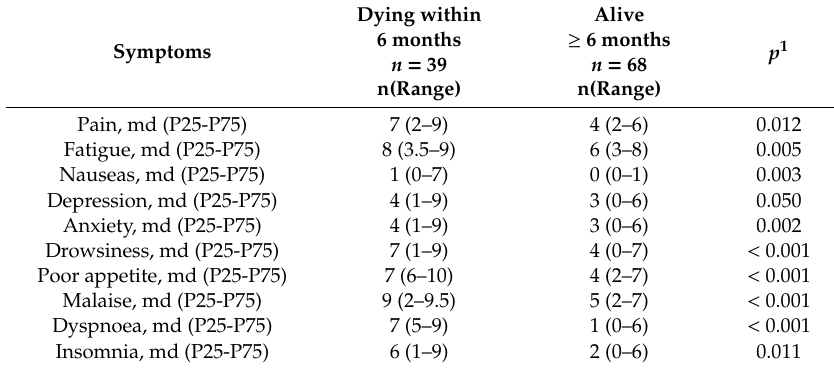
Table 3. Comparison of symptoms using ESAS in residents of nursing homes who died with those who did not